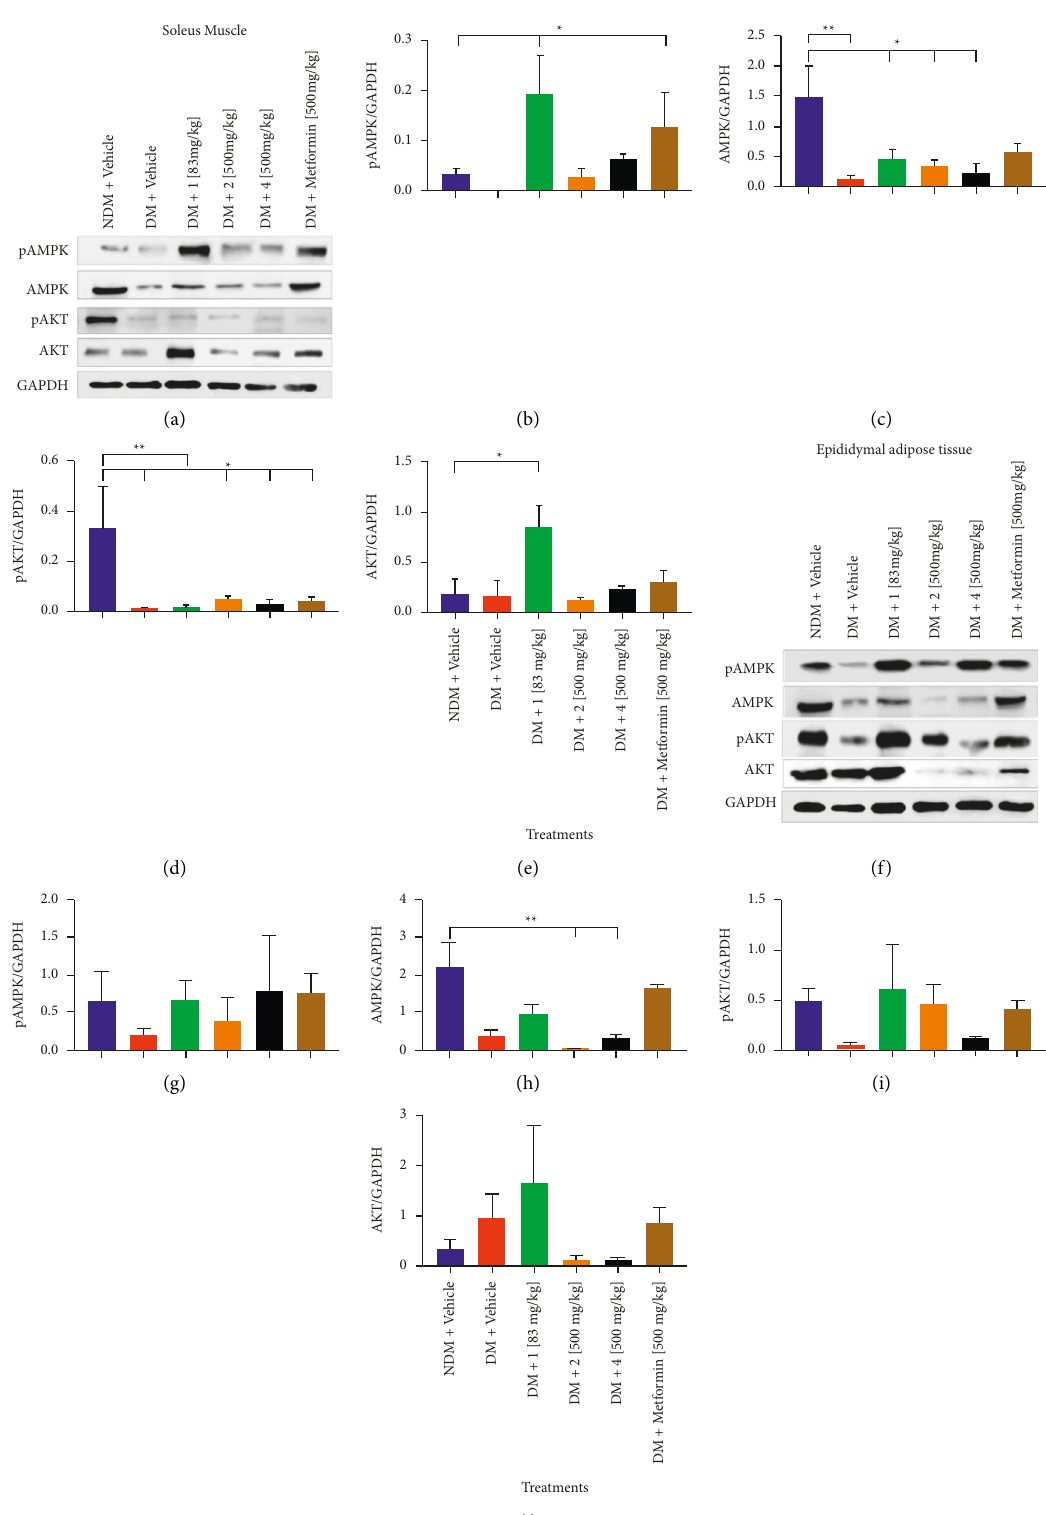
Figure 6: Measurement of second messengers involved in Glut4 translocation in soleus muscle and epididymal adipose tissue. (a) Representative western blot of pAMPK, AMPK, pAKT, and AKTexpression in the soleus muscle of the treated groups. (b) Densitometry analysis of the pAMPK/GAPDH ratios in SM. (c) Densitometry analysis of the AMPK/GAPDH ratios in SM. (d) Densitometry analysis of the pAKT/GAPDH ratios in SM. (e) Densitometry analysis of the AKT/GAPDH ratios in SM. (f) Representative western blot of pAMPK, AMPK, pAKT, and AKTexpression in epididymal adipose tissue from the treated groups. (g) Densitometry analysis of the pAMPK/GAPDH ratios in EAT. (h) Densitometry analysis of the AMPK/GAPDH ratios in EAT. (i) Densitometry analysis of the pAKT/GAPDH ratios in EAT. (j) Densitometry analysis of the AKT/GAPDH ratios in EAT. The error bars represent the standard error mean of measurements for n